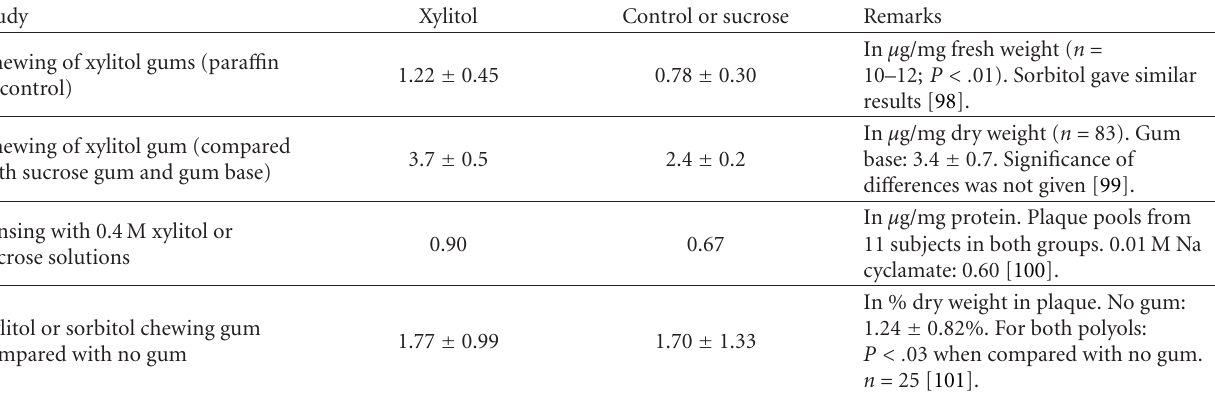
Table 4: Concentration of calcium (determined by means of atomic absorption spectrophotometry) in dental plaque of subjects who used products containing